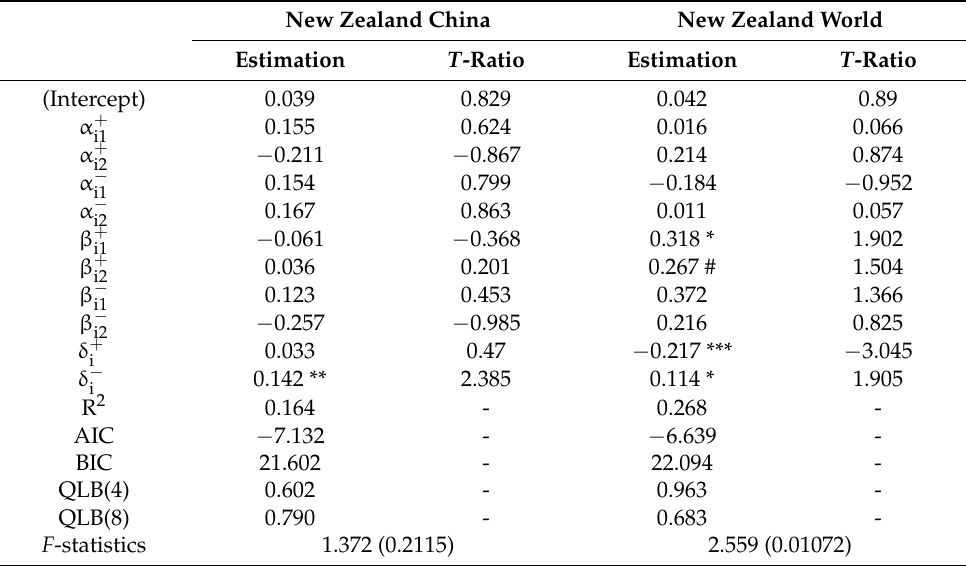
Table 6. Results of the asymmetric error correction model with threshold cointegration for New